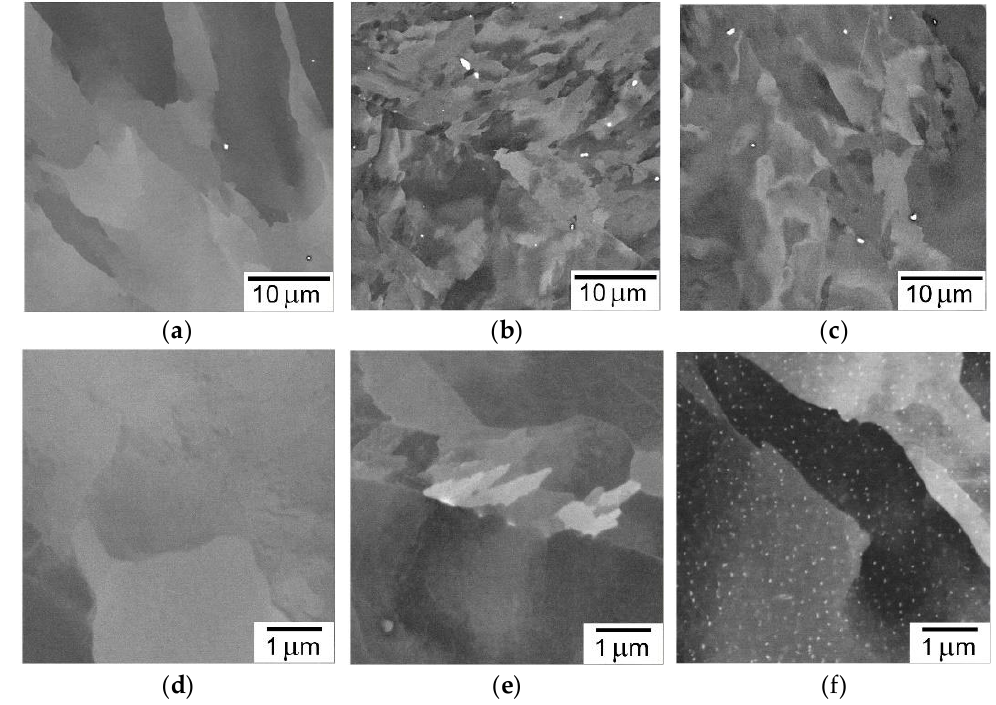
Figure 1. Backscattered electron (BSE) images of the alloys for creep tests at low ( a – c ) and high ( d – f ) magnifications: ( a , d ) 0.03 Hf alloy, ( b , e ) 0.09 Hf alloy, ( c , f ) 0.33 Hf alloy. Fine particles observed in ( f ) are Fe 2 Hf Laves phase. Relatively coarse particles observed in ( a – c ) are Hf containing carbide/carbonitride.